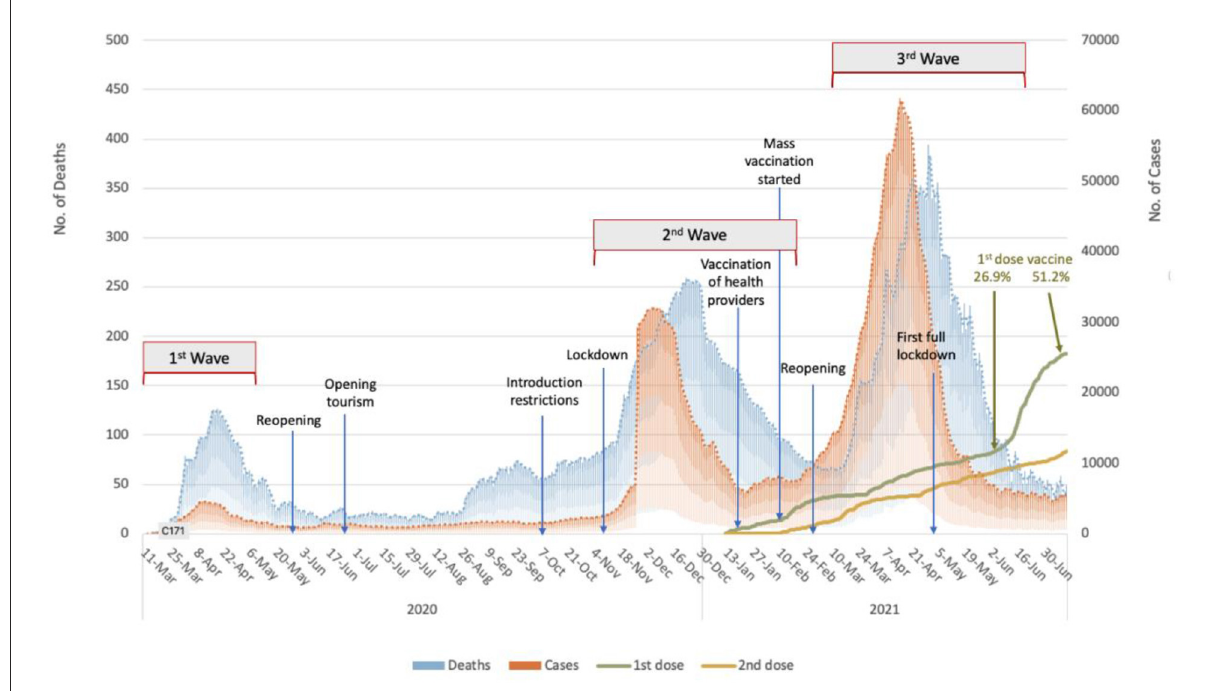
FIGURE2 The epidemic curve of the COVID-19 pandemic in Turkey with the lockdowns/openings and vaccination rates between March 2020 to June 2021 (The authors produced the curve to explain the temporal flow).